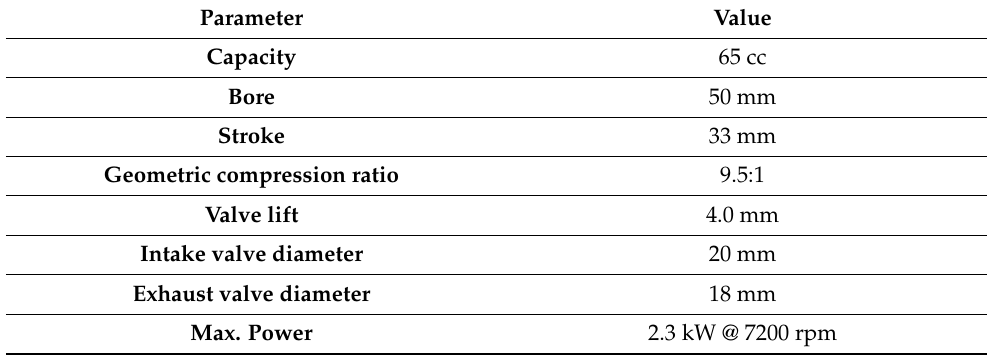
Table 3. The 65 cc version of the Stihl 4MIX engine selected for the design.